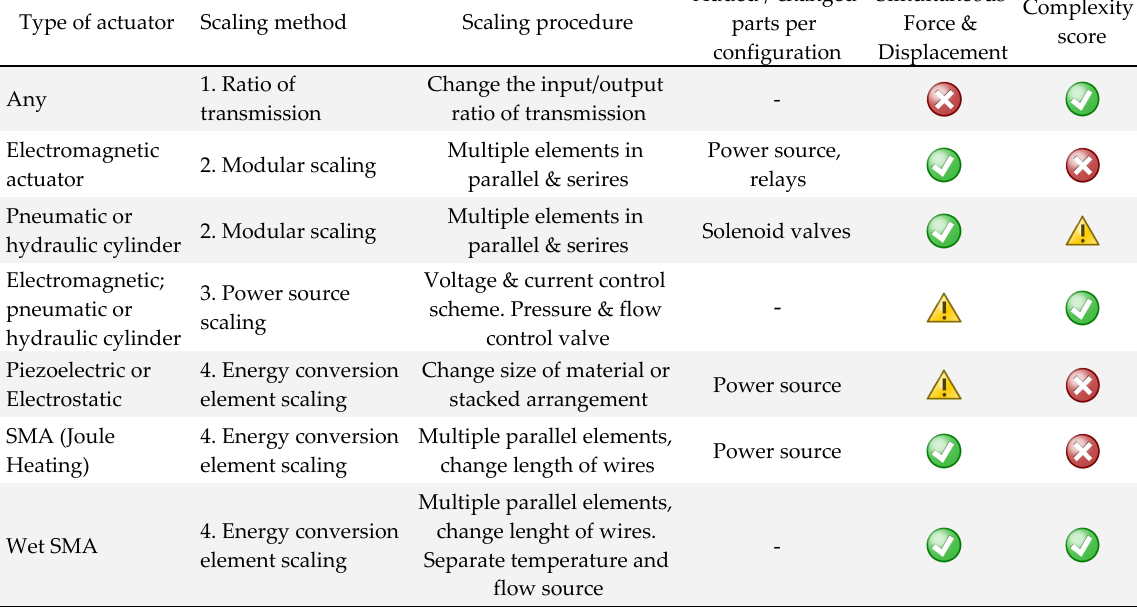
Figure 2. Scalability evaluation of conventional